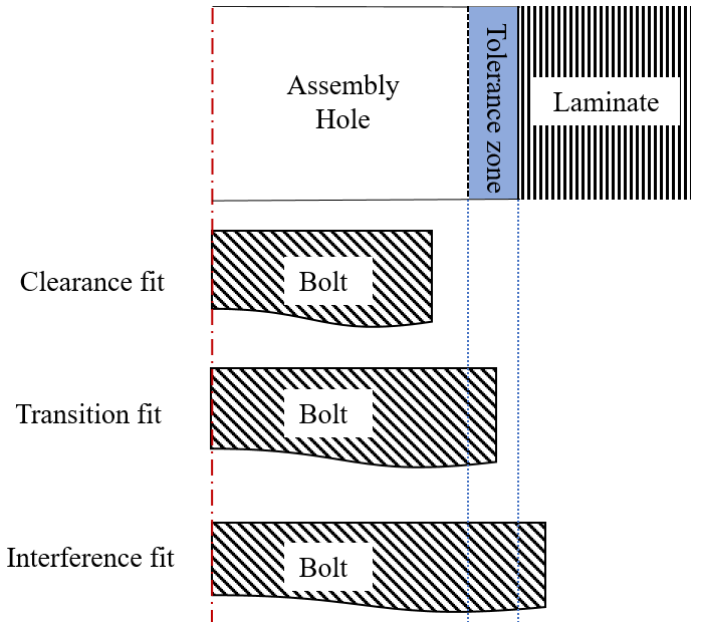
Figure 7. Sketch of three kinds of fit in bolted joints. The test results for the double-shear joint with three bolts are plotted in Figure 8. It is observed that the pin-load ratio changed slightly with the increase in the external applied load, which was induced by the brittleness of the composite. This was totally different from the pin-load distribution ratio of the metal materials. Furthermore, it is known that, due to the good plasticity of the metal bolt material, the pin-load distribution ratio tends to be more evenly distributed with the increase in the applied